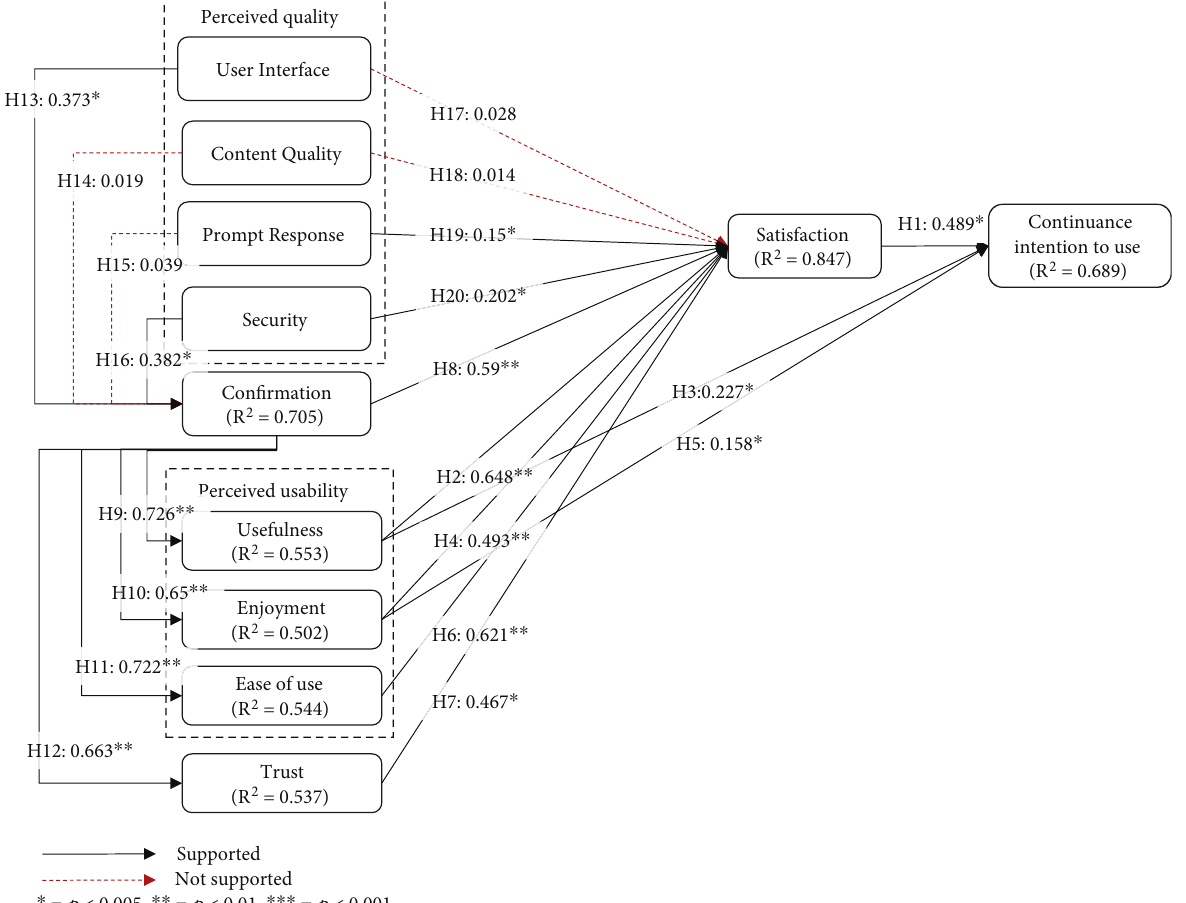
Figure 2: Structural model